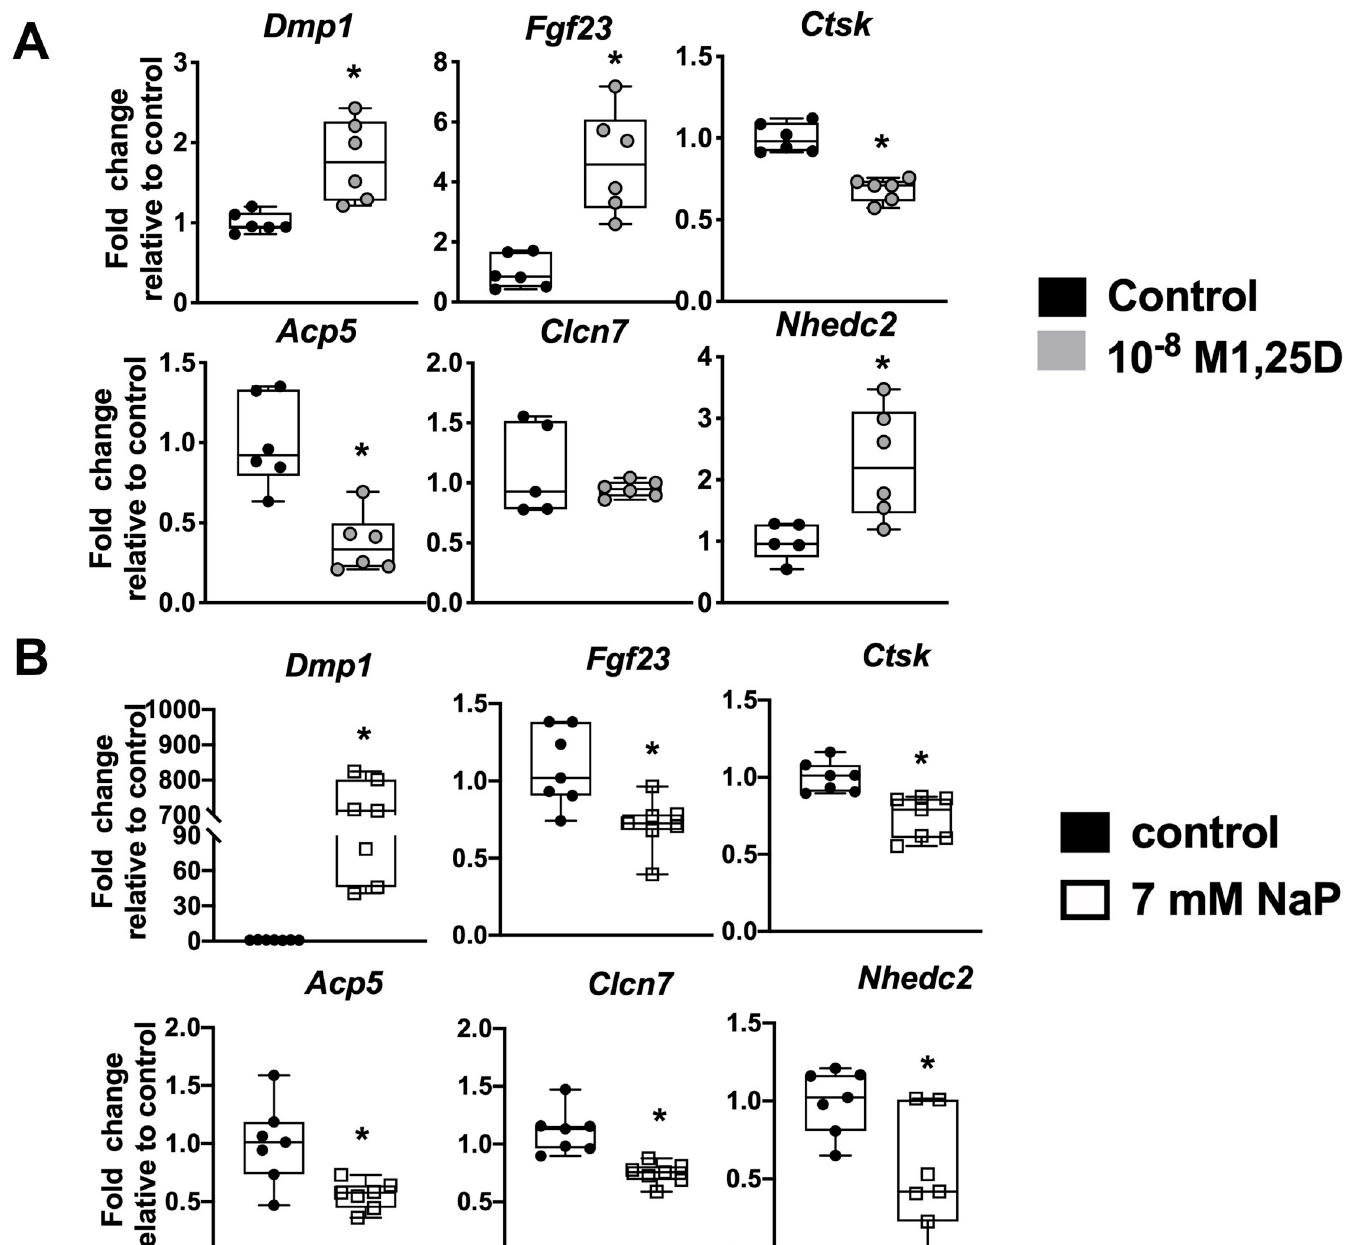
Fig 7. 1,25D and phosphate treatment of Ocy454 cells decreases expression of genes implicated in perilacunar matrix resorption. Ocy454 cells were treated with 24 hours of control or 10 -8 M 1,25D (A) or 7 mM sodium sulfate (control) or sodium phosphate for 8 hours (B). Gene expression of Dmp1 , Fgf23 , and markers of perilacunar remodeling were quantitated. Data are representative of that obtained from at least 5 biological replicates. � p < 0.05 vs